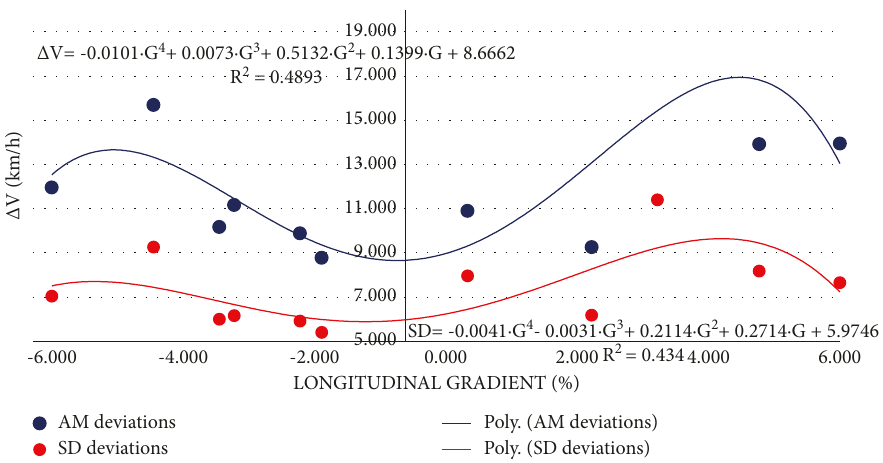
Figure 4: Deviation of traffic flow speeds as a function of longitudinal gradient.